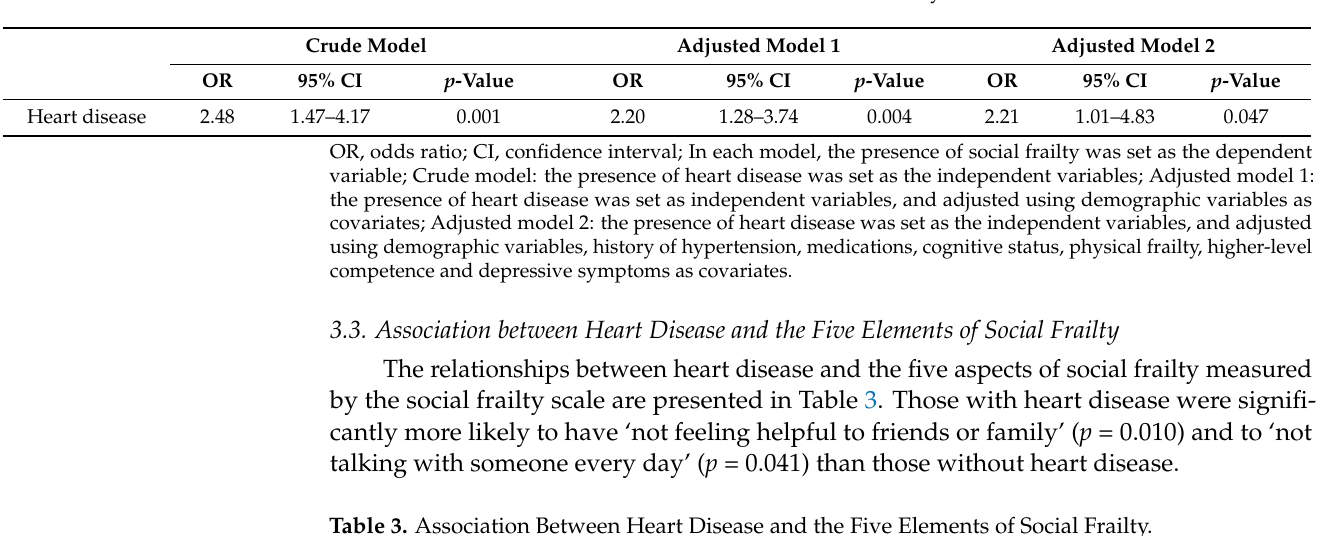
Table 2. Association Between Heart Disease and Social Frailty.